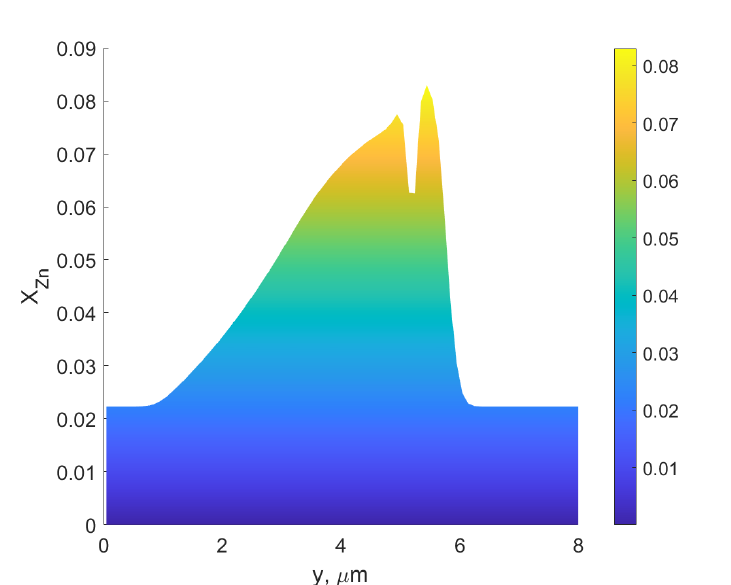
Figure 11. X Zn profile at the surface after 20